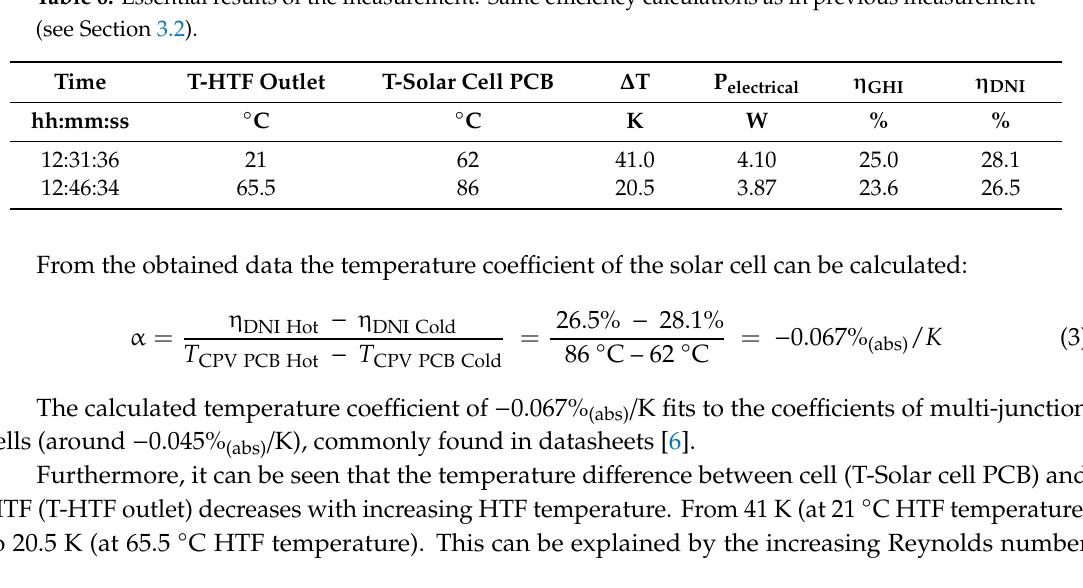
Figure 20. IV-curve and electrical power of the solar cell measured at 12 h:31 min:36 s (focus on the center of the cell). The maximum power point (MPP) of 4.1 W at 2.6 V can be seen.